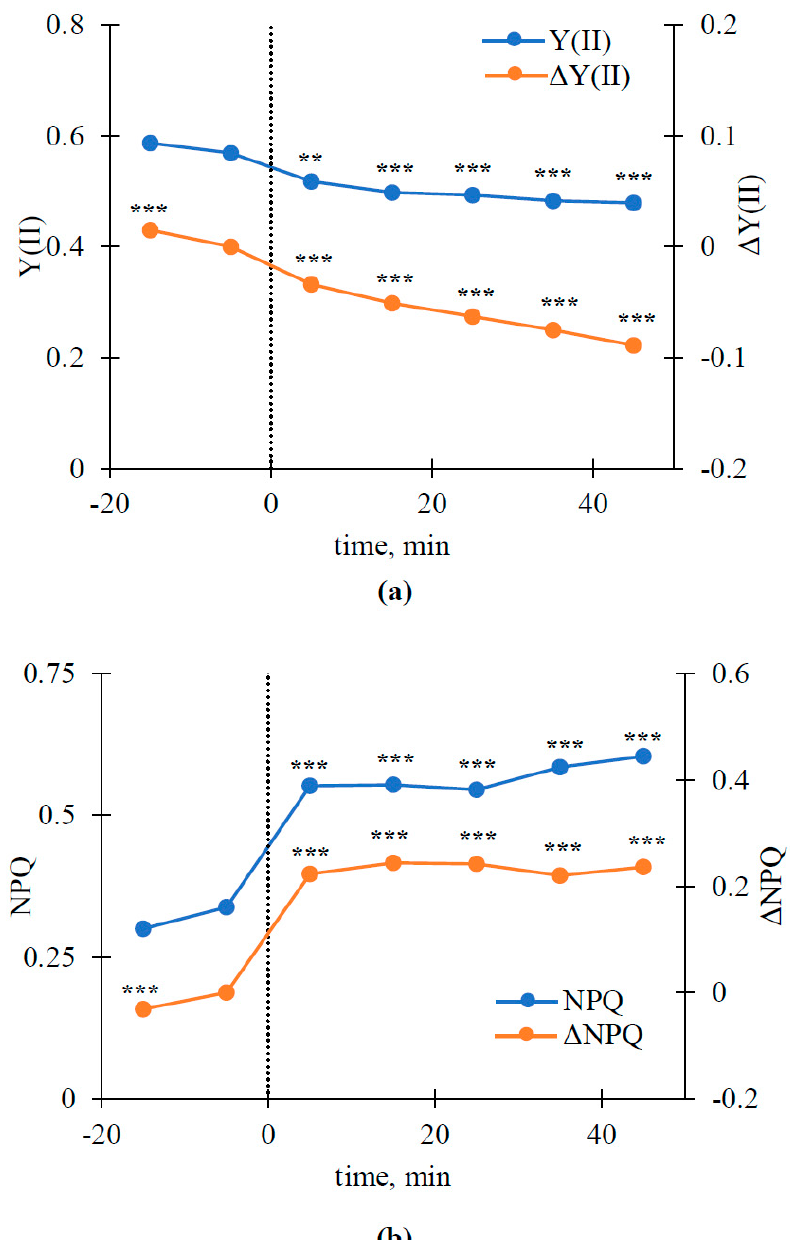
Figure 4. Dynamics of Y(II) and Δ Y(II) ( a ) and NPQ and Δ NPQ ( b ) before and after induction of variation potential in the second leaf ( n = 13). Burning the first leaf was used for VP induction (the burning is marked by the time point zero and dotted line). ∆ Y(II) and ∆ NPQ were calculated as Y(II) TP -Y(II) C and NPQ TP -NPQ C , respectively. Y(II) C is the control Y(II) at 5 min before VP induction. Y(II) TP is Y(II) at a specific time point before or after VP induction. NPQ C is the control NPQ at 5